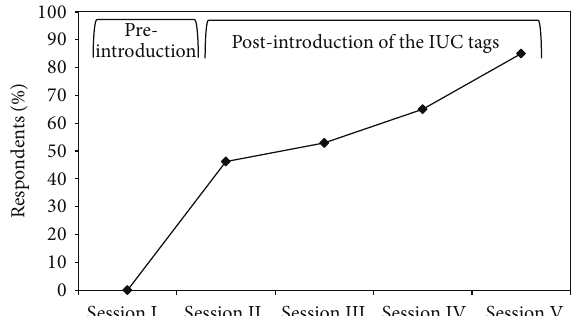
Figure 2: The nursing self-reported catheter tagging increased